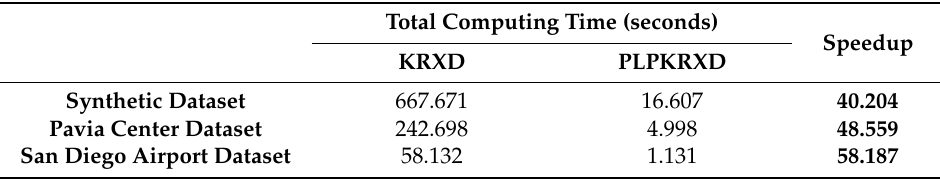
Table 3. Total processing time for three HSI